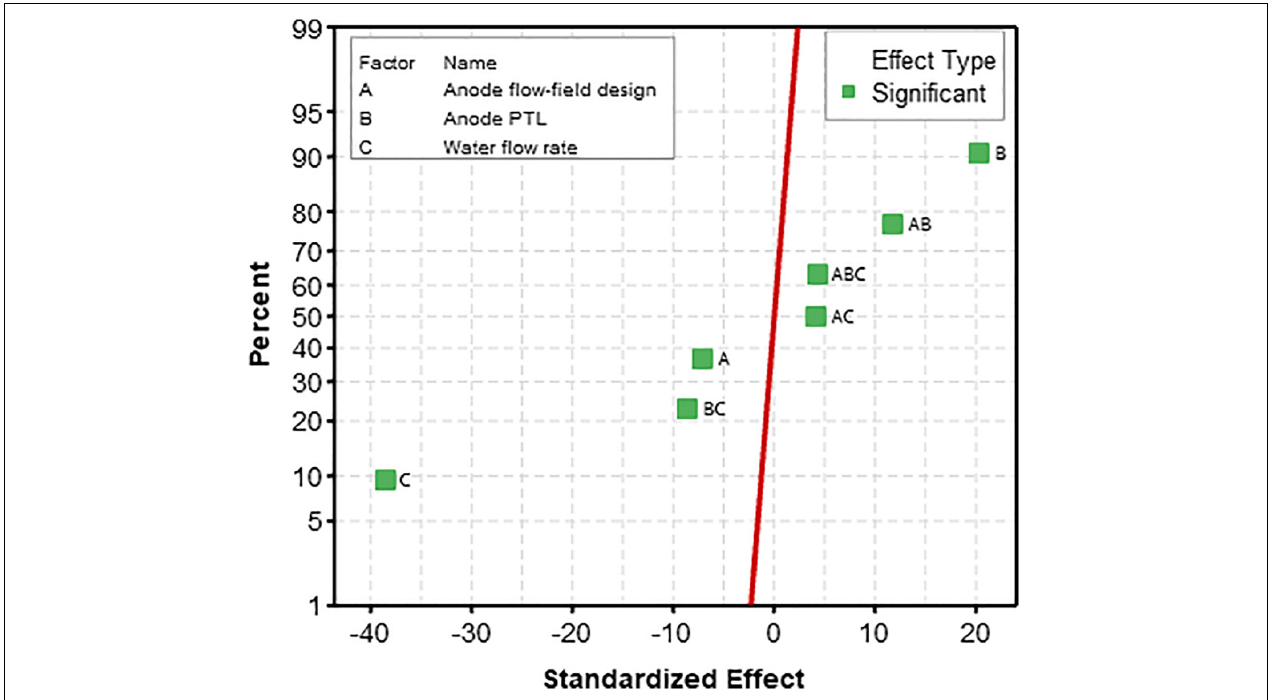
FIGURE 4 | Normal plot of standardised effects of the mass transport parameters. The red line indicates where all the effects are zero. The effects furthest away from the line shows the most significant influence on output